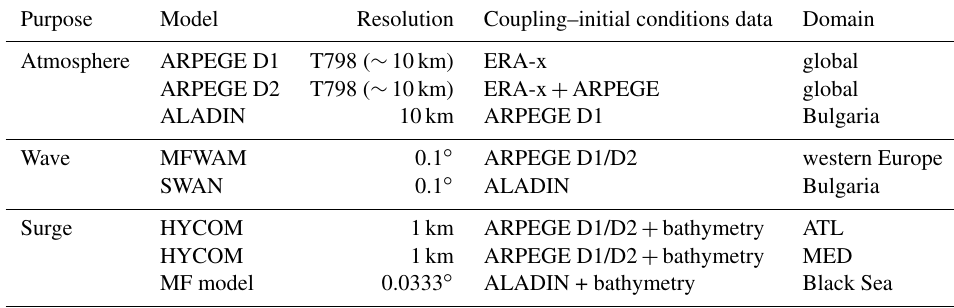
Table 3. Outline of the numerical models required for wave and storm surge hindcasts.